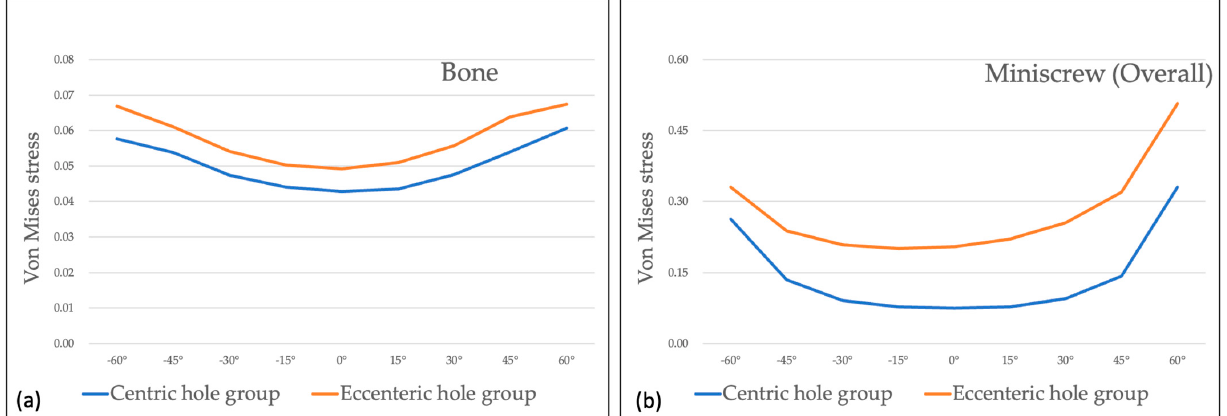
Figure 7. Von-Mises stress under 1 ° of counter-clockwise rotation at the alveolar bone and miniscrew at various angles: ( a ) Von-mises stress at the alveolar bone showing the higher stress in the centric hole group; ( b ) Von-Mises stress at the whole miniscrew showing the higher stress in the centric hole group and at positive angles.